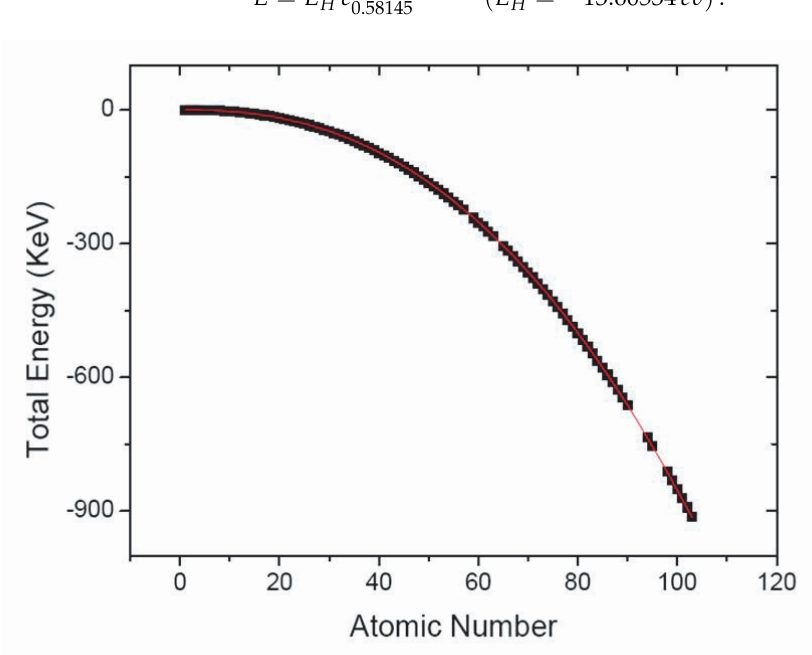
Figure 21. Ground-state energy E of the free atom as a function of the atomic number Z . The results from hydrogen to lawrencium are presented. The red line has been calculated with Equation (63). From